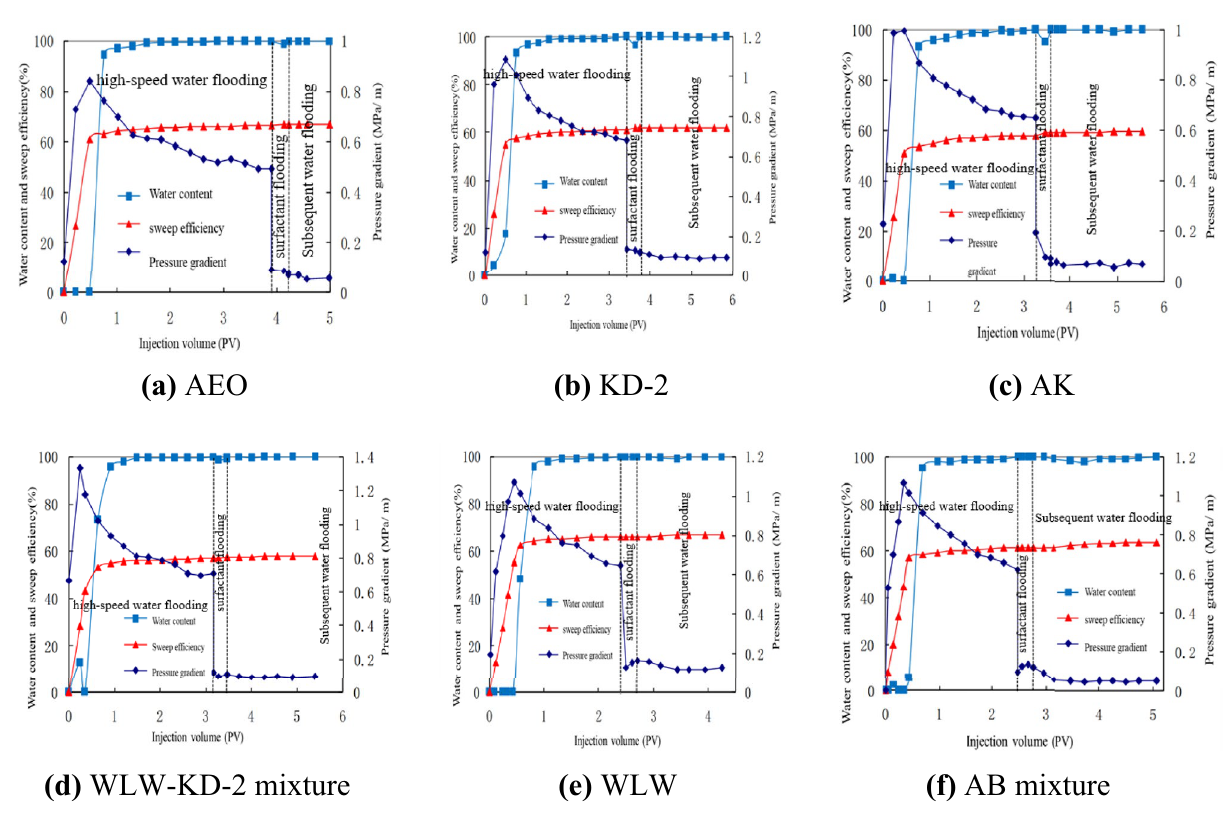
Fig. 9 Core flooding experiment results of different surfactant and surfactant mixtures